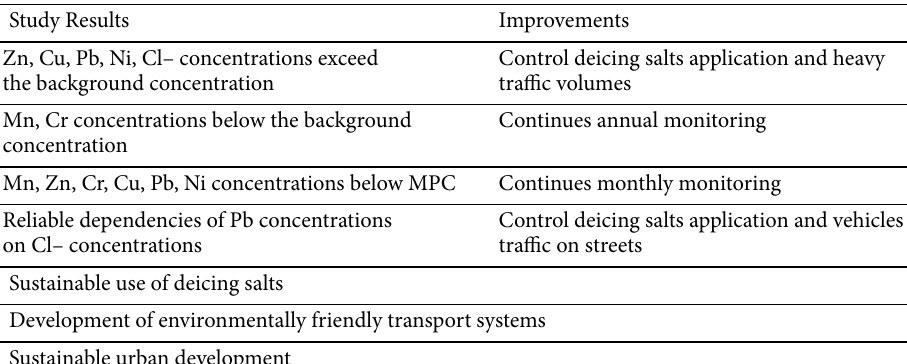
table 2. Compliance with sustainable urban development study